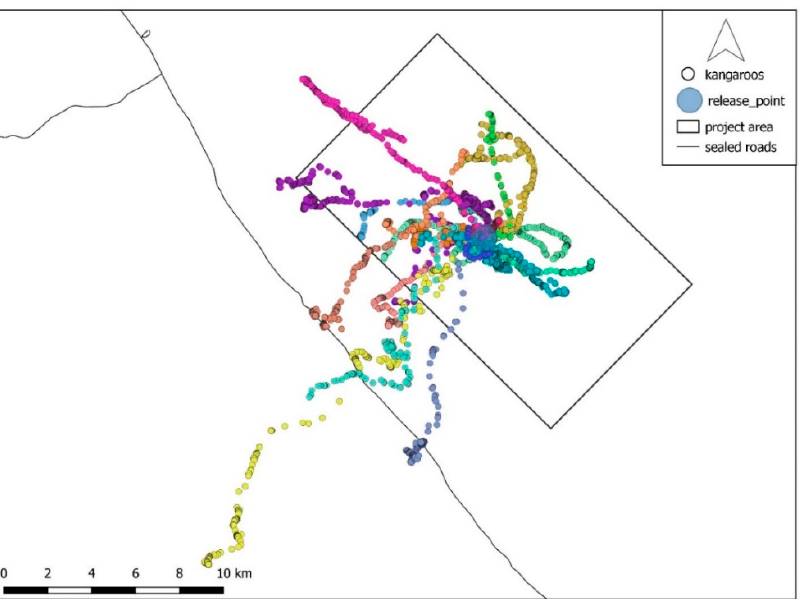
Figure A4. Movement of surviving GPS collared western grey kangaroos (triangles) and the primary areas they occupied (polygons) following relocation.